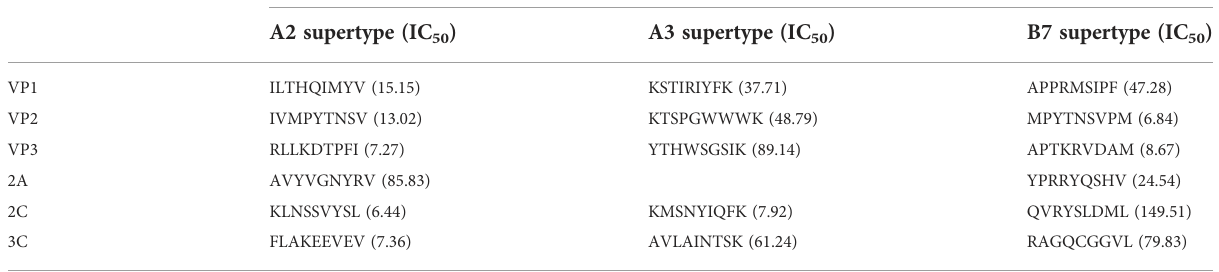
TABLE 2 Predicted cytotoxic T lymphocyte (CTL) epitopes of CVB proteins utilized for the construction of a novel multi-epitope vaccine. Protein